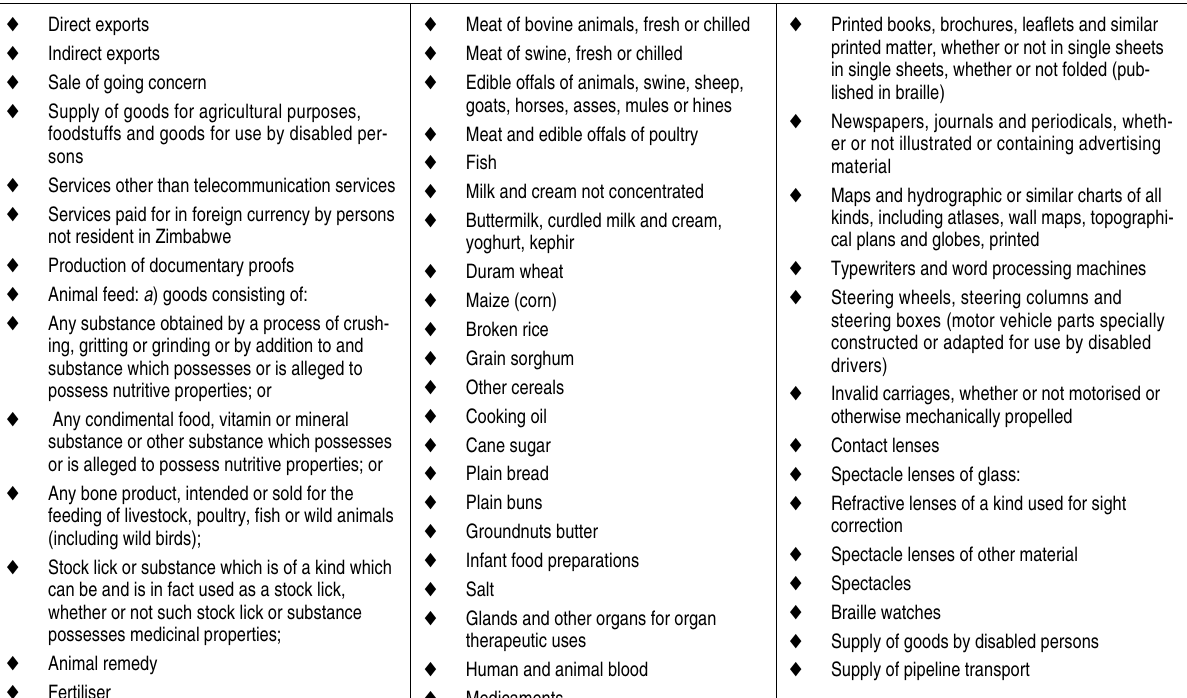
Table 2. Goods currently on the Zimbabwe exempt and zero rated